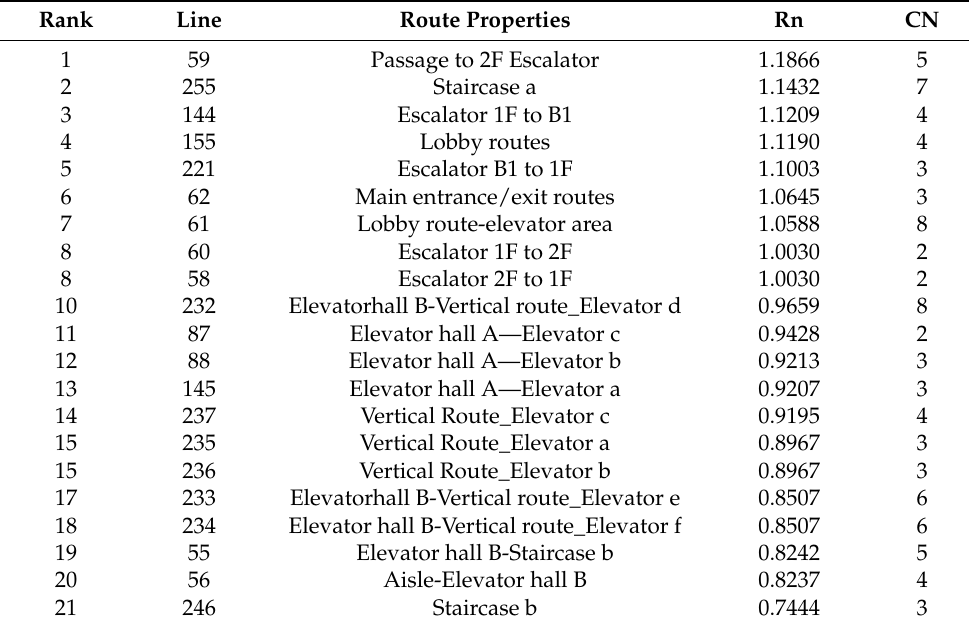
Table 2. The quantification of the dynamic syntax of the major and vertical routes on the first floor of the CCH/CKB